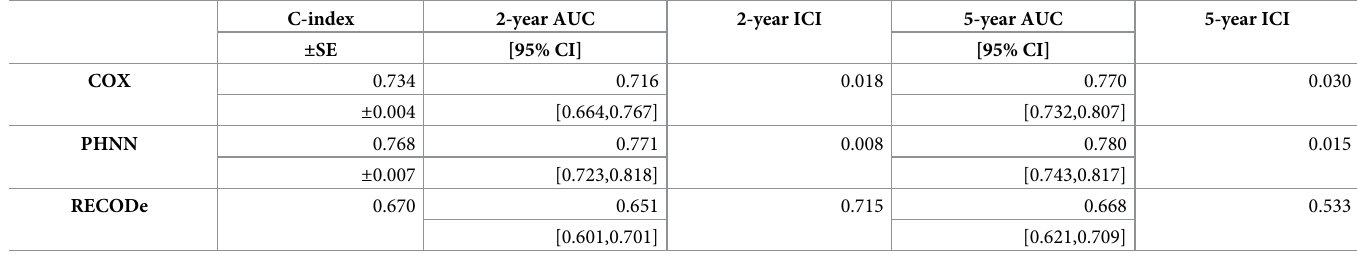
Table 2. Performance of the three models. SE = standard error; AUC = Area under the ROC curve; ICI = integrated calibration index; CI = confidence interval.